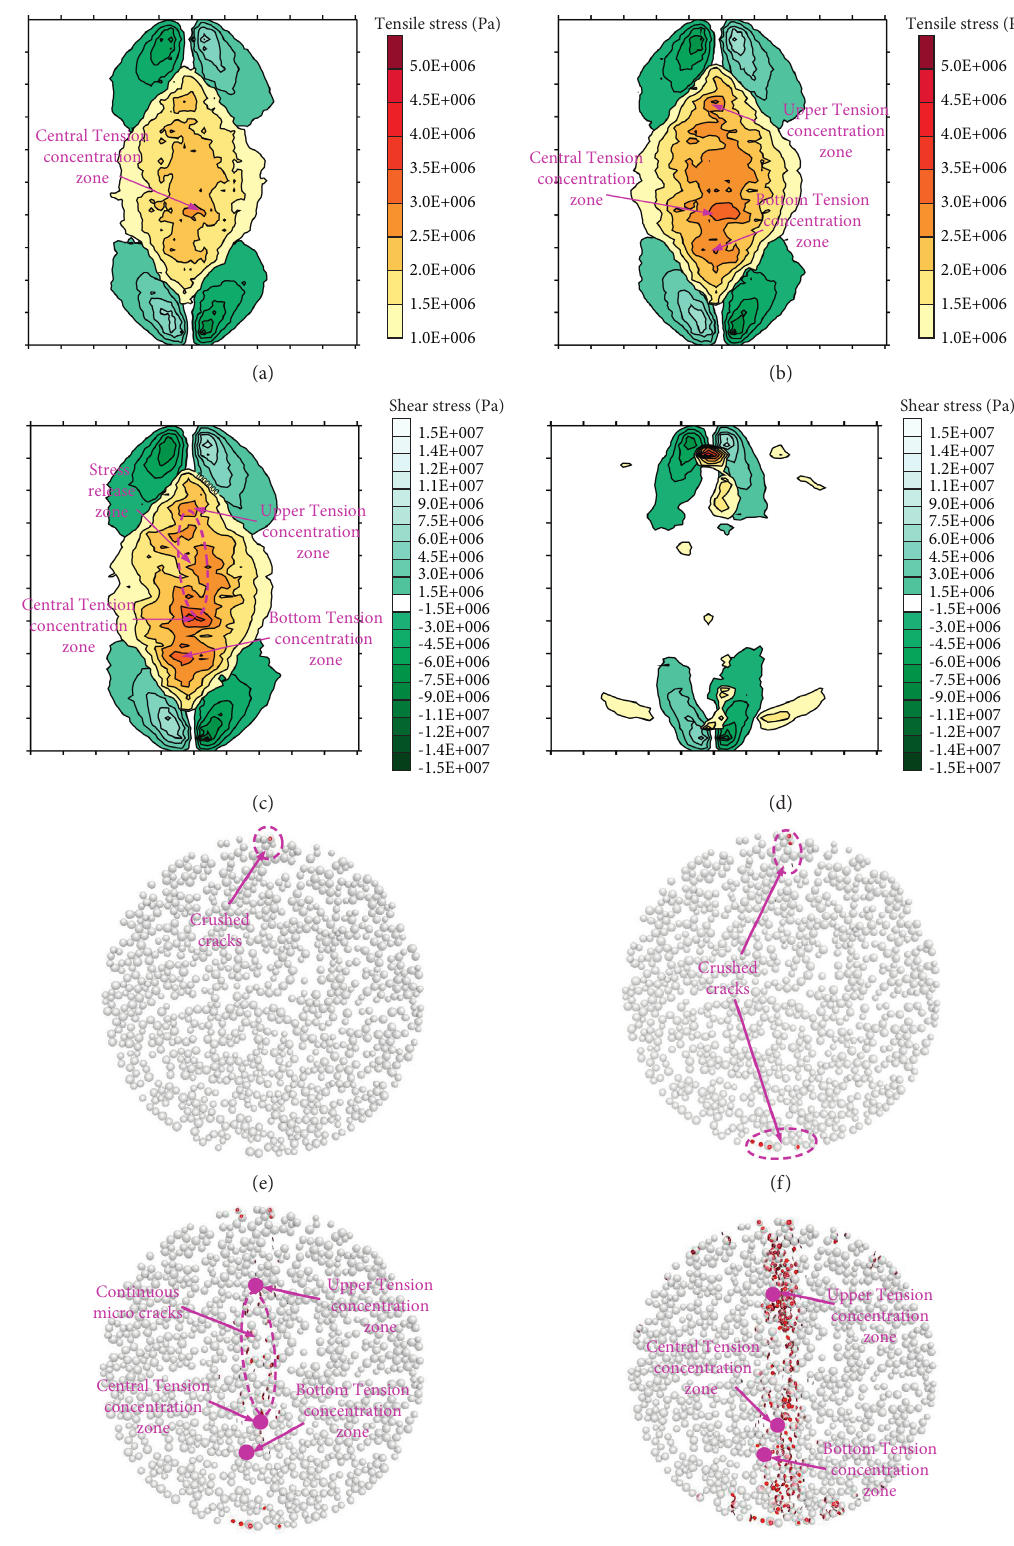
Figure 14: Stress conditions and crack propagations at the monitor points on the vertical ABC plane for the BTtests: (a–d) stress conditions; (e–h) crack